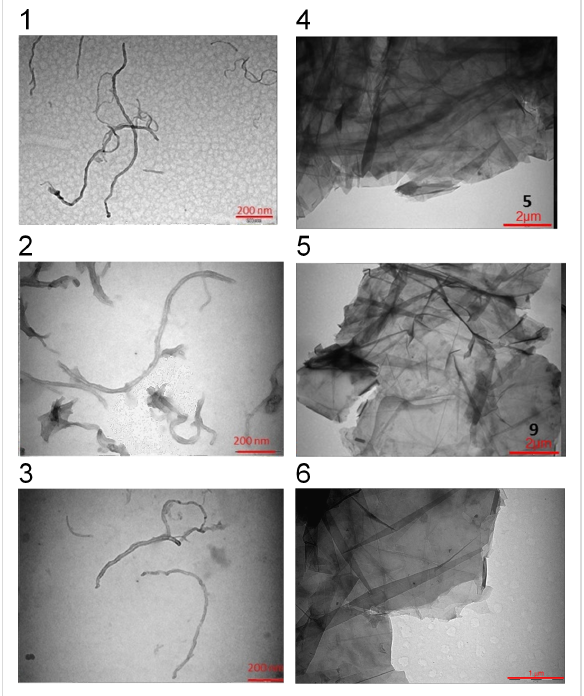
Figure 4: TEM images of ox-MWCNTs 4 (1), ox-MWCNTs-PO 6 (2), ox-MWCNTs-Nit-PO 8 (3), GPs 5 (4) GPs-PO 7 (5), GPs-Nit-PO 9 (6).